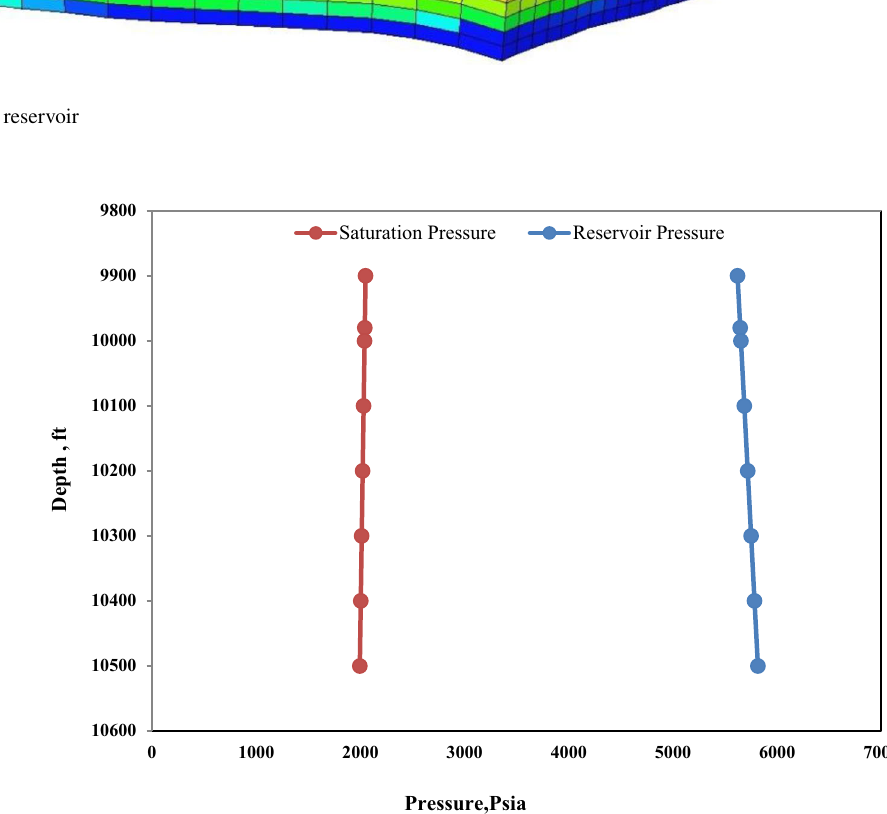
Fig. 2 Three-dimensional model of the reservoir